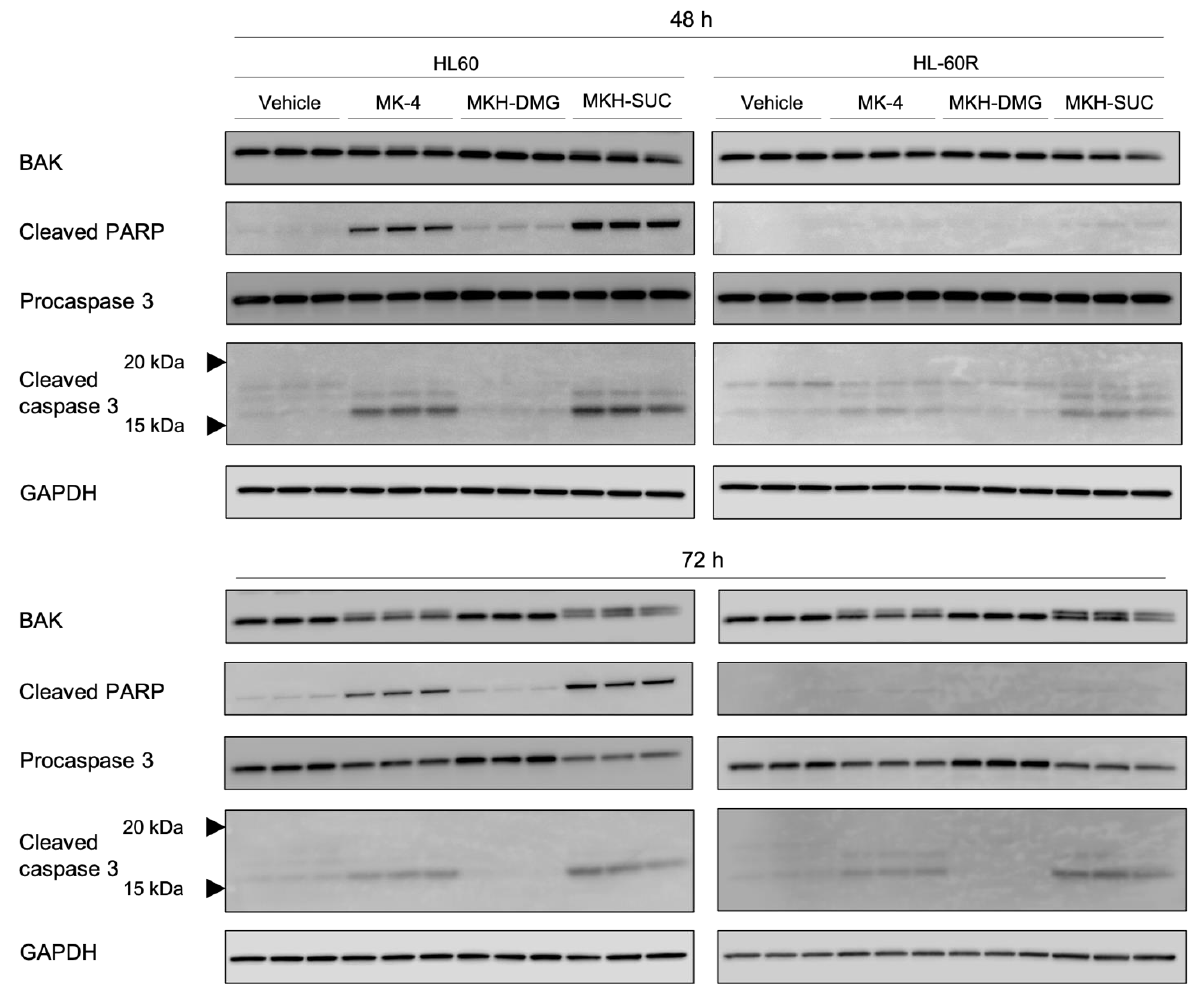
Figure 9. Effects of MK-4 and MKH derivatives on the expression of apoptosis-related proteins in HL60 and HL-60R cells. HL60 and HL-60R cells were treated with 10 µM MK-4, MKH-DMG, or MKH-SUC for 48 and 72 h. Th expression of BAK, cleaved PARP, and pro/cleaved caspase-3 was analyzed by Western blotting.